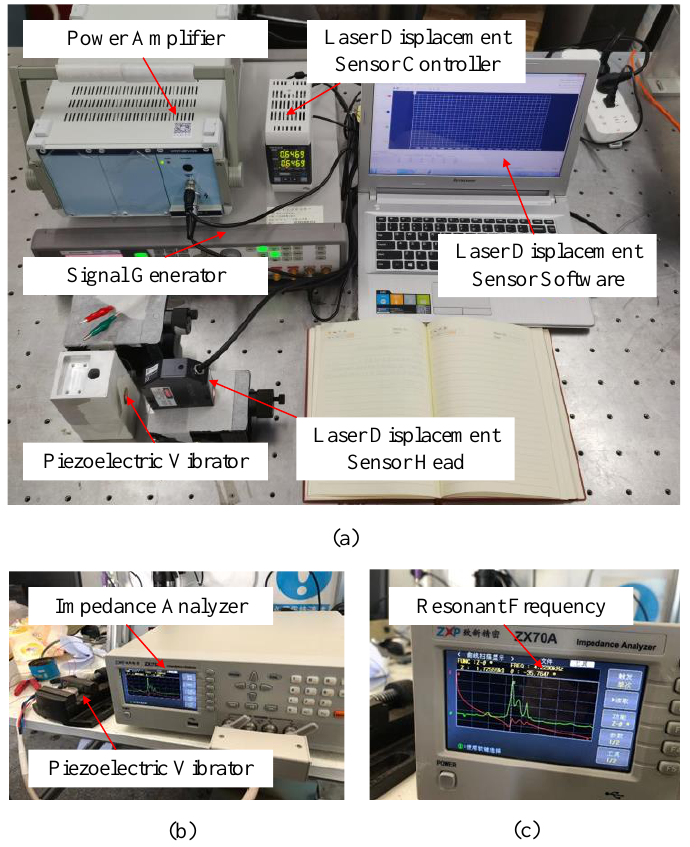
Figure 4. Test platforms of piezoelectric vibrators: ( a ) test platform of amplitude; ( b ) sweep test platform; ( c ) impedance analysis waveform diagram.